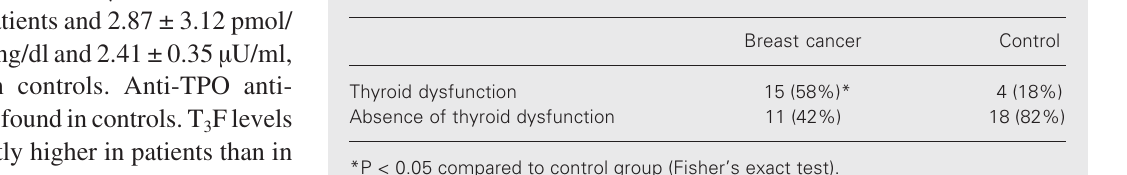
Table 2. Distribution of thyroid hormone dysfunction in patients with breast cancer and controls.